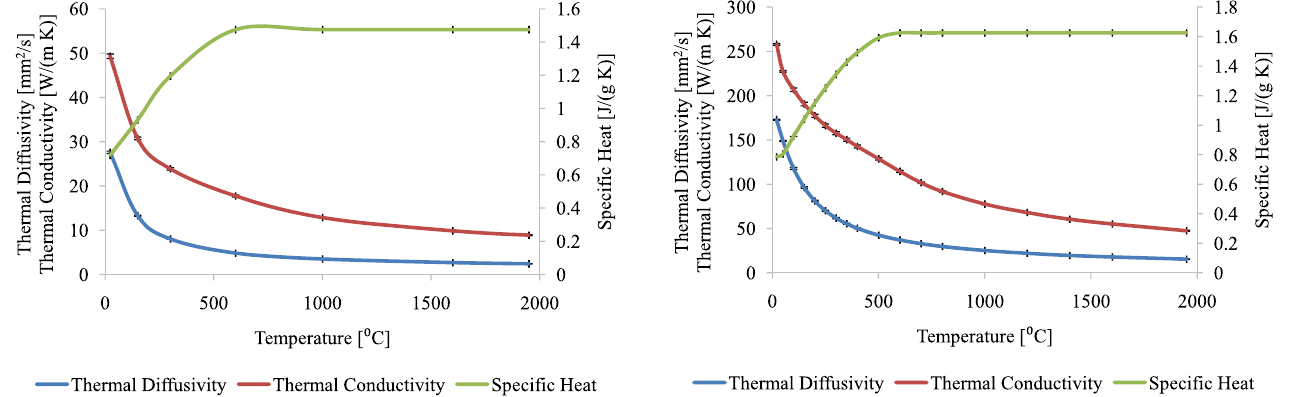
FIG. 6. Plot of thermal diffusivity, thermal conductivity and specific heat against temperature for MoGr along ( T ).